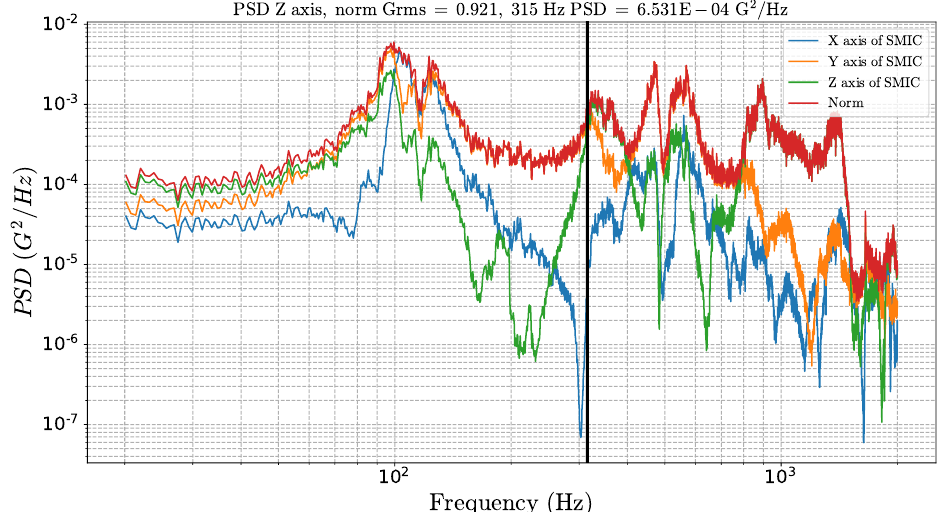
Figure 7. Power spectral density applied to the SMIC. Showing the natural frequency of the solar array derived using finite-element modelling (315 Hz) with a black line. | PSD | shown in red, PSDs measured along individual SMIC axes in other colors.